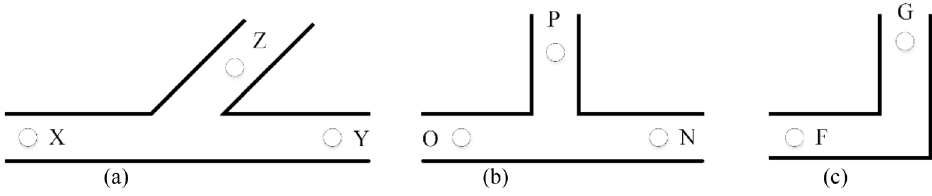
Figure 10. Pipeline types used in the